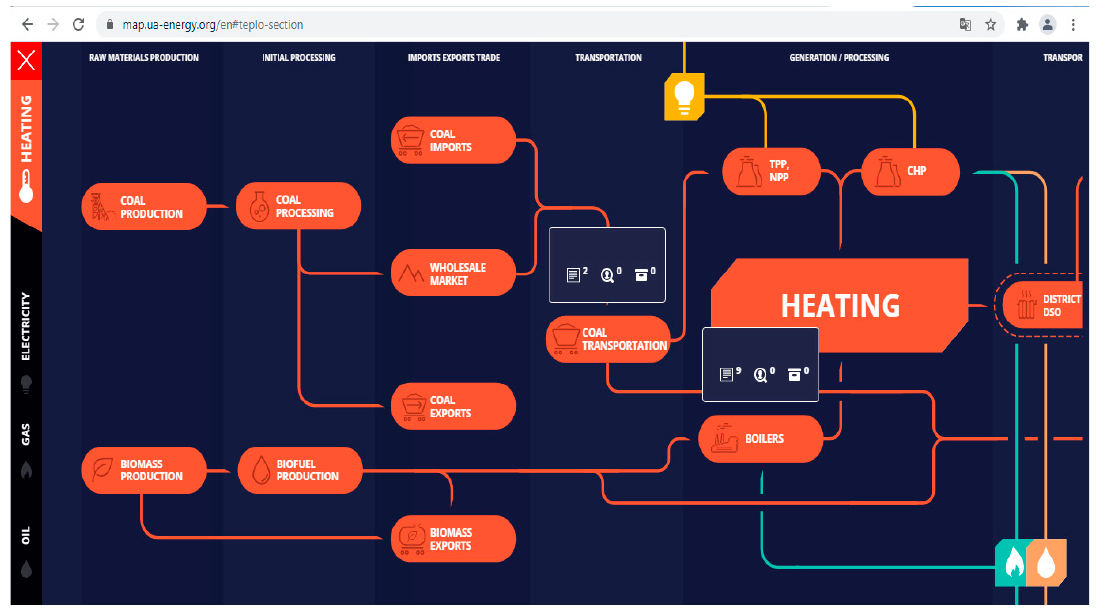
Figure 8. Chains of heat generation technologies in Ukraine based on traditional, non-traditional and renewable energy sources in the online map of the energy sector of Ukraine “UA MAP” (reproduction of graphic material from [36]).